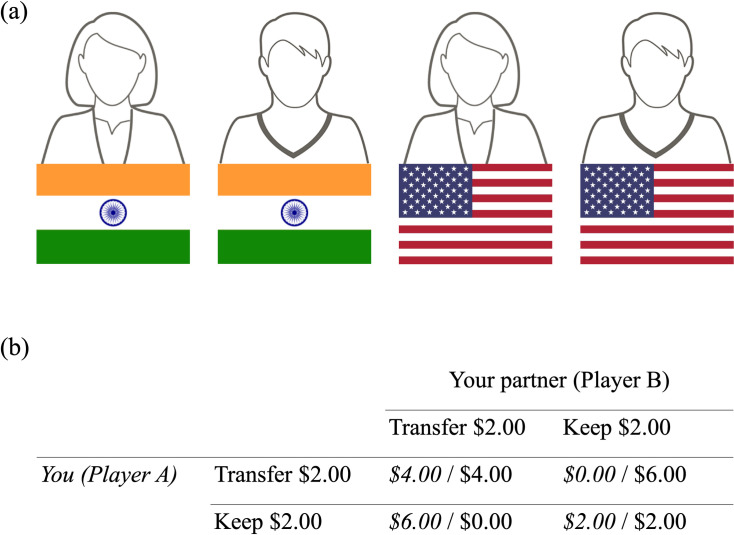
Stimuli used in the study.(a) Avatars that represented (from left to right) Indian female, Indian male, US American female, US American male partners in the Dictator Game and Prisoner’s Dilemma, as well as presented during the Affect Misattribution Procedure. (b) The Prisoner’s Dilemma payoff matrix that participants saw as instructions. The participant, Player A, had two options: they could transfer $2.00 to Player B or keep $2.00 for themselves. Payoffs on the left (italicized) are participant payoffs, while payoffs on the right are Player B payoffs.